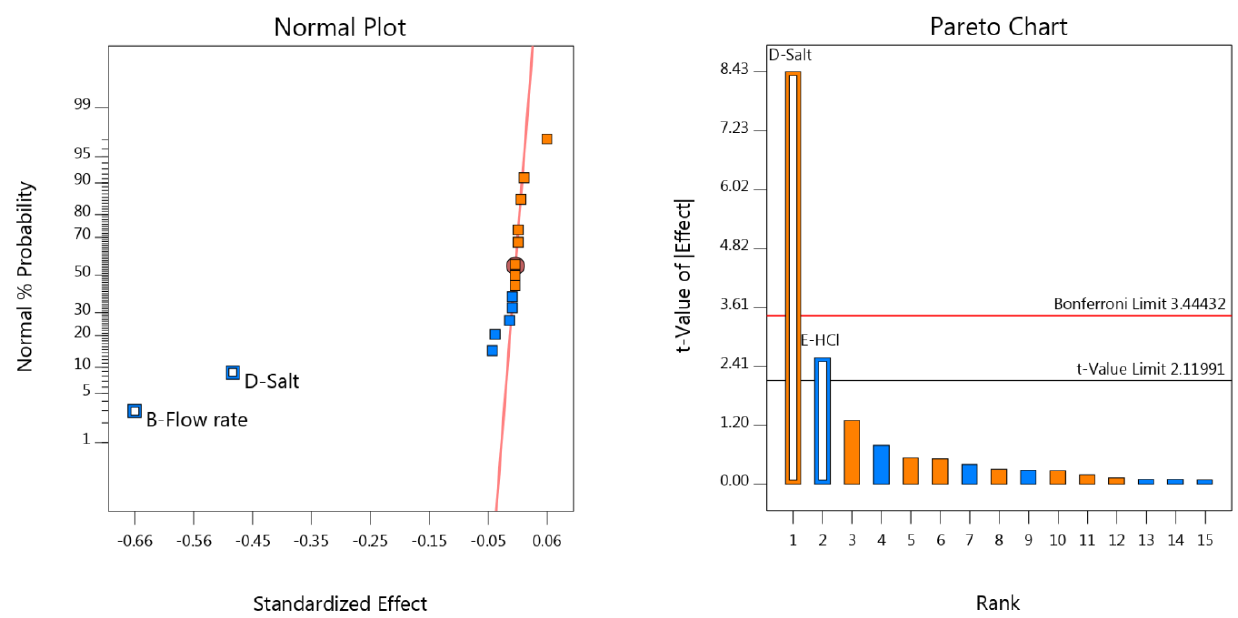
Figure 4. Representative normal plot graph for the response of NTX · HCl tR ( left ) and Pareto chart for the response of BUP · HCl (N) ( right ). A: %ACN; B: flow rate (mL/min); C: wavelength (nm); D: salt concentration (mM); E: HCl concentration (M).